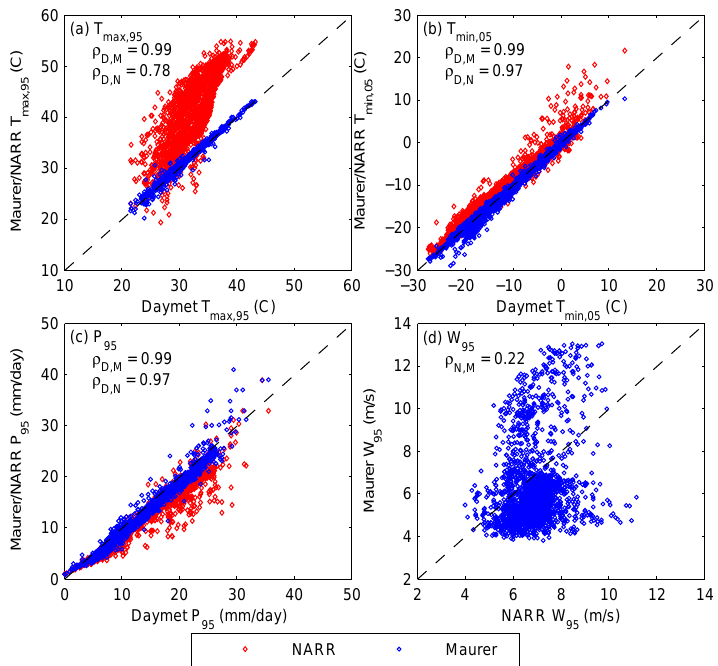
Fig. 4. Comparison among the 1980–2008 Daymet, Maurer, and NARR (a) mean annual 95% quantile daily maximum temperature T max,95 , (b) mean annual 5% quantile daily minimum temperature T min,05 , (c) mean annual 95% quantile daily precipitation P 95 , and (d) mean annual 95% quantile daily wind speed W 95 . Each point represents the HUC8 annual average over the entire